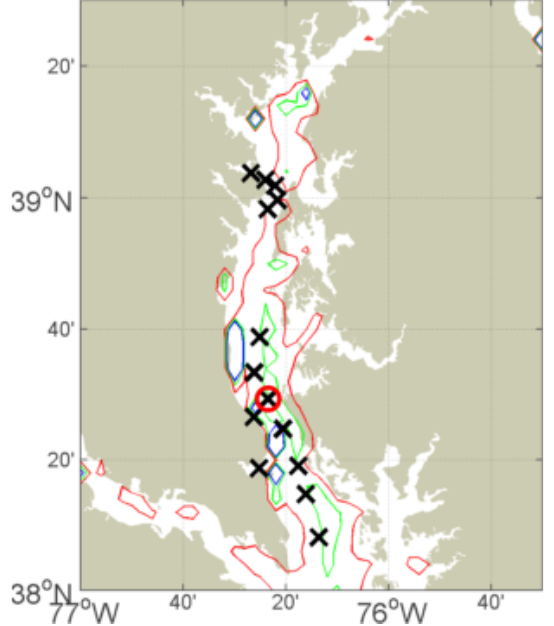
Fig. 1. The sampling locations and bathymetry (red, green and blue contours: 5, 15 and 25m water depths) in the Chesapeake Bay. The circle highlights station CB3, for which inversion results are shown in Fig.